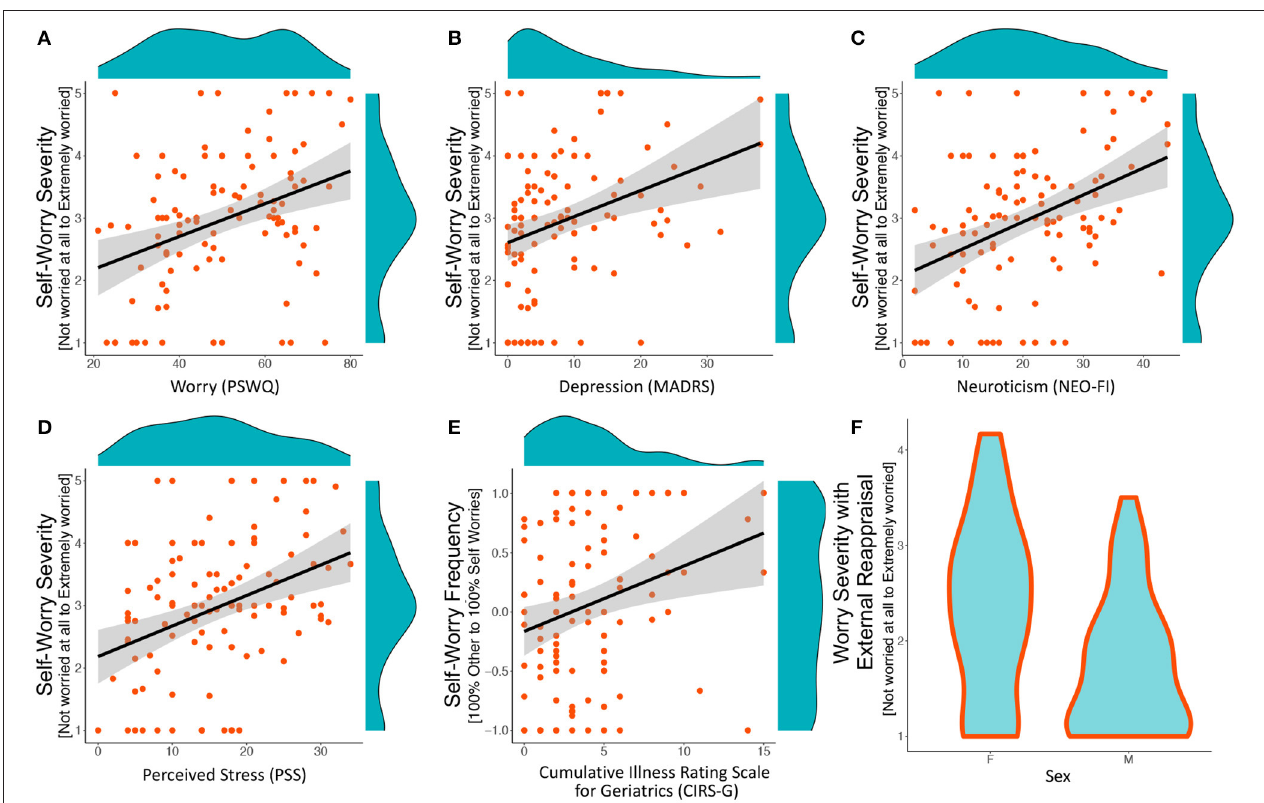
FIGURE 1 | Significant associations from elastic net analyses. Plots A–E include a scatter plot, a least–squares line with 95% confidence intervals, and histograms in the margins. Plot F is a violin plot showing a mirrored histogram. (A–D) Associations between self–worry severity (average severity of self–focused worries) and clinical measures of worry, depression, neuroticism, and stress. (E) Association between self–worry frequency (frequency of self–focused worry among worry statements) classified as self–focused worries and CIRS–G (cumulative illness). (F) Violin plots showing differences between females and males on worry severity following external locus of control in reappraisal. This is a measure of worry severity after being shown the reappraising statements; therefore, higher values indicate greater worry despite being shown a reappraising